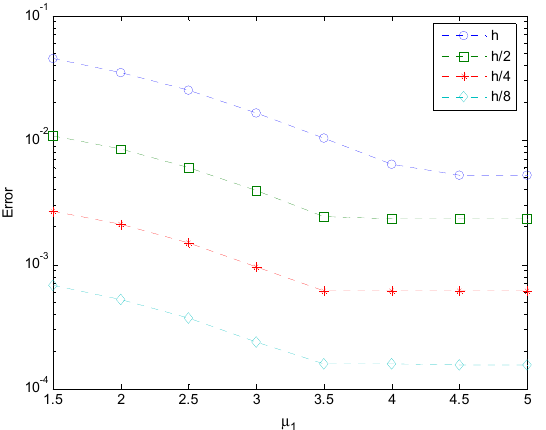
(cid:2998) (Ω ) errors against 𝑁 for Example 1 (𝜇 Figure 4. L ∞ ( Ω i ) errors against N for Example 1 ( µ 1 = 2 ) . Figure 4. 𝐿 (cid:3036) Figure 4. 𝐿 (cid:2998) (Ω (cid:3036) ) errors against 𝑁 for Example 1 (𝜇 (cid:2869) = 2) .